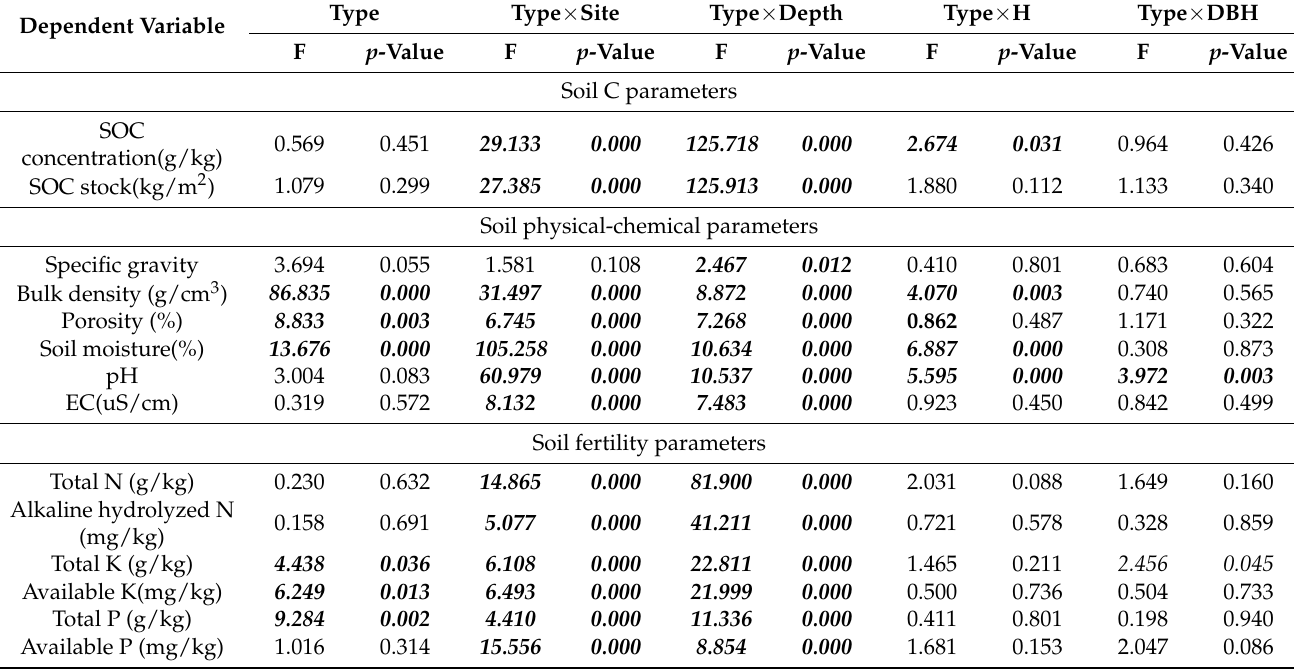
Table 1. Effect shelterbelts construction on SOC, physical-chemical and fertility parameters, and possible interaction effect from sites, soil depths, and tree growth